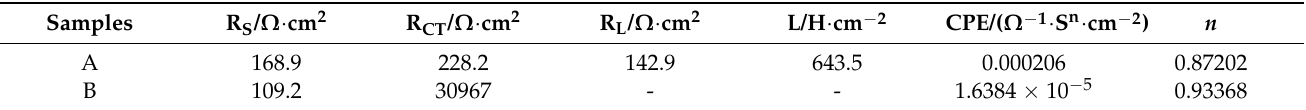
Table 3. Estimated parameters of the equivalent circuit elements for Mg–Li alloy substrate and optimized upper surface Ni–P coating.